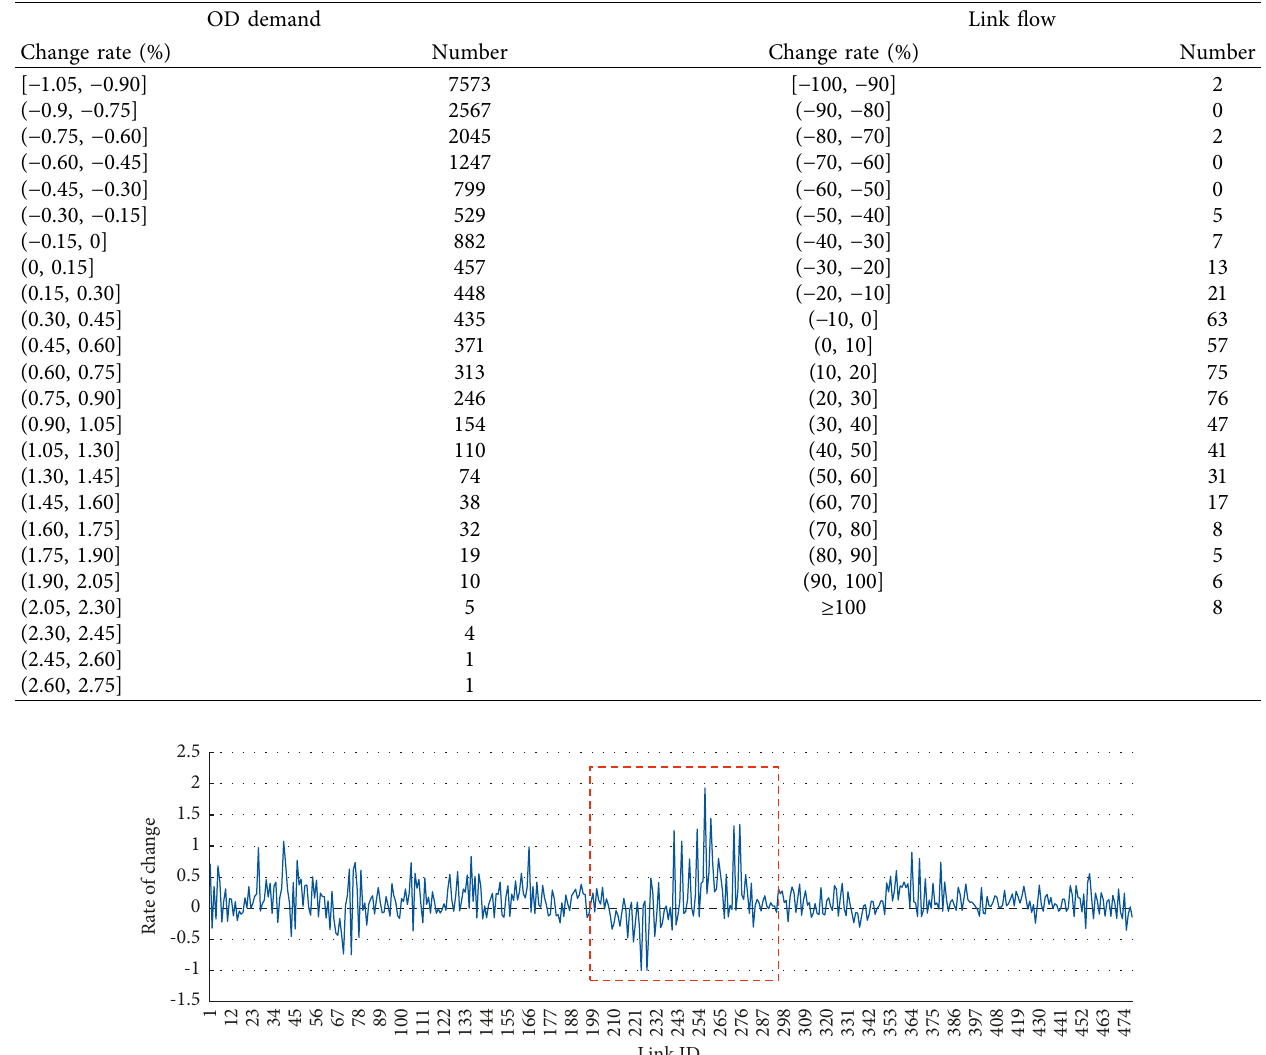
Figure 9: The change rate of link